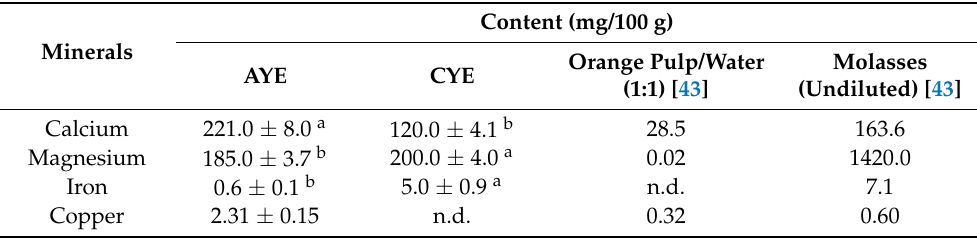
Table 3. Mineral content of the alternative yeast extract (AYE) in comparison with commercial yeast extract (CYE).